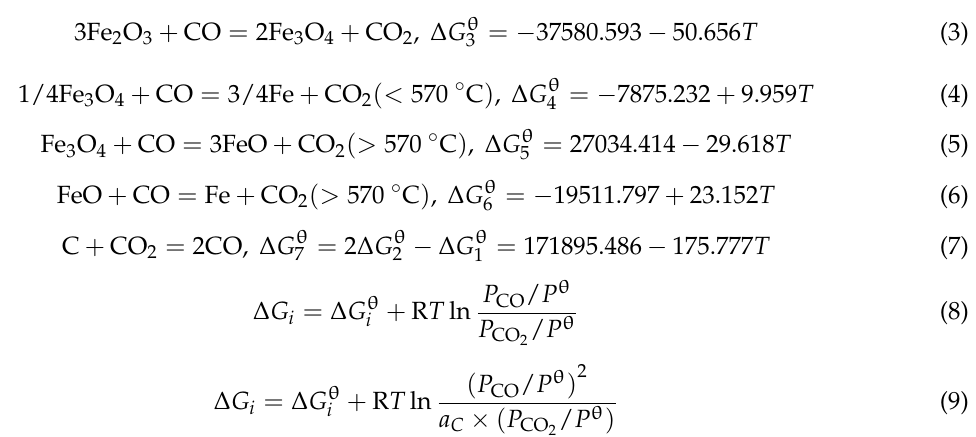
Figure 2. Equilibrium diagram of the reduction of iron oxides by CO.